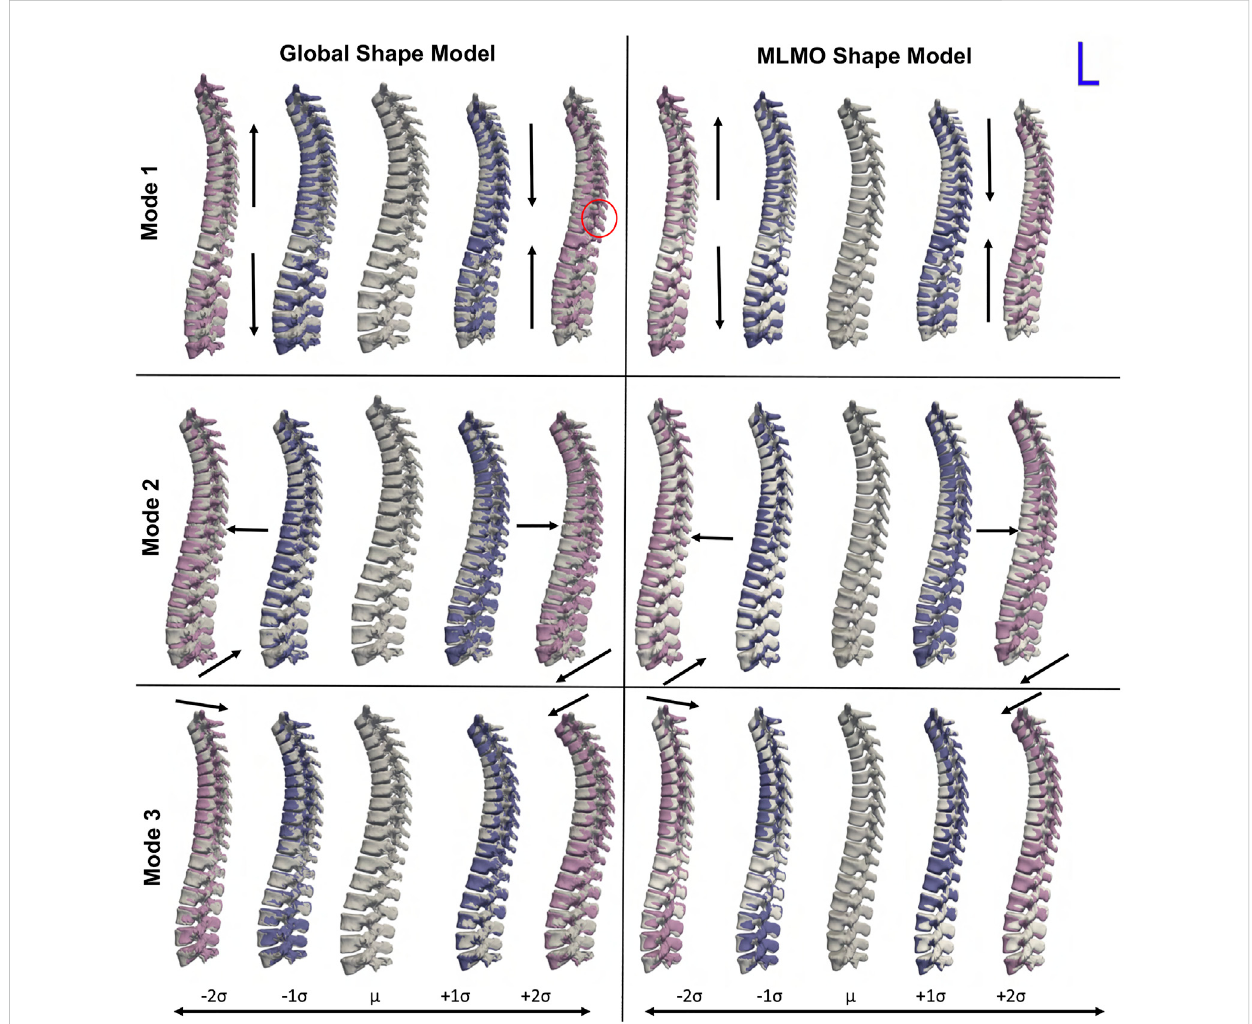
FIGURE 4 Between-organmodes ofvariation showingrelativeposevariationsinthespinal column. Themeanshapeisgreyincolor with±1 σ modesshown in blue and ± 2 σ modes shown in pink color. Some of the anatomical inconsistencies are highlighted in red circles and signi fi cant pose variations are annotated using